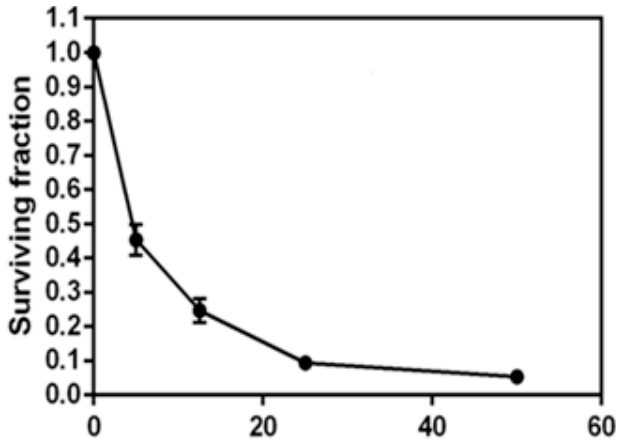
Figure 3. Viability curve of compound ( 21a ), with cytotoxic activity against H1299 NSCLC cell line.